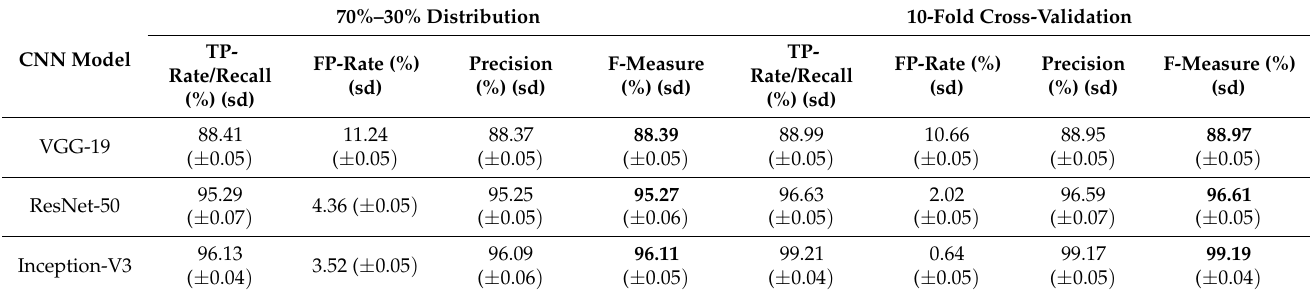
Table 7. Performance of CNN models with respect to diverse metrics using dataset